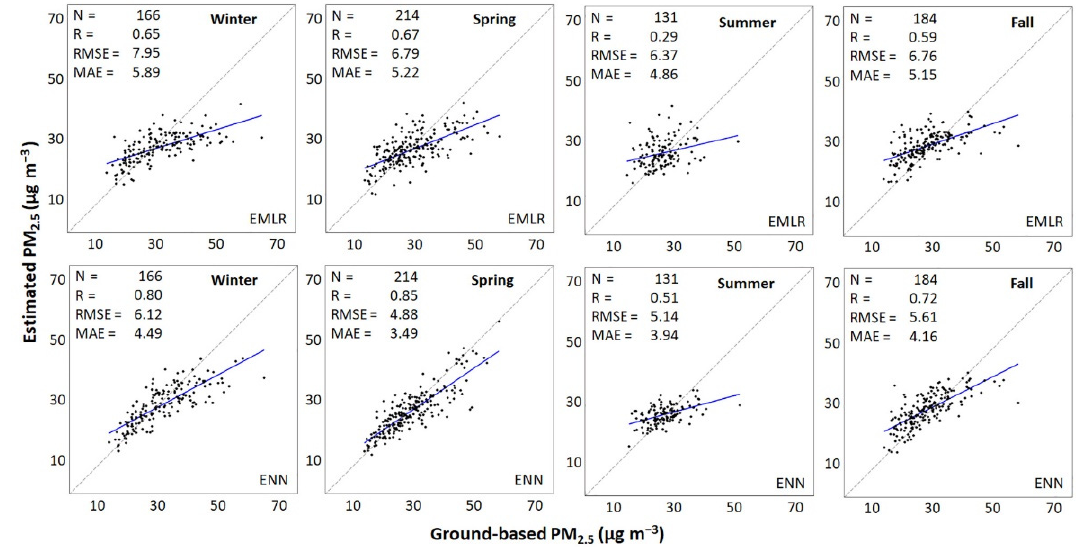
Figure 8. Seasonal model performance of ground-based versus estimated PM 2.5 concentrations: EMLR model performance ( top ) and ENN model performance ( bottom